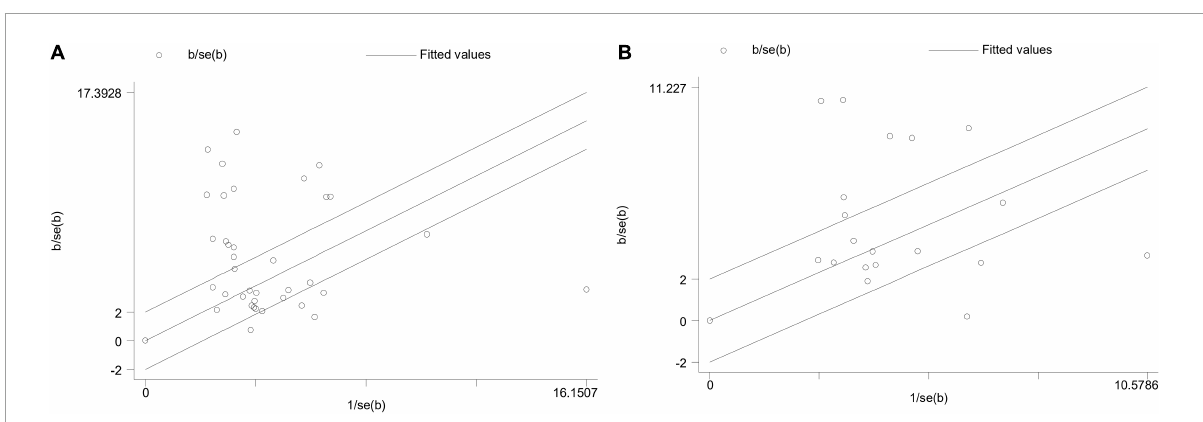
FIGURE8 Galbraith plot analysis of heterogeneity. (A) Galbraith plot of knowledge examination scores; (B) Galbraith plot of comprehensive ability